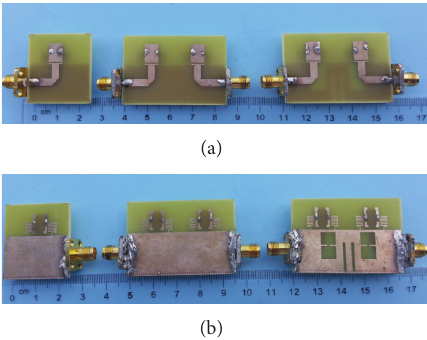
Figure 13: Fabrication of the single metamaterial antenna; initial and final MIMO antenna (a) front view and (b) back